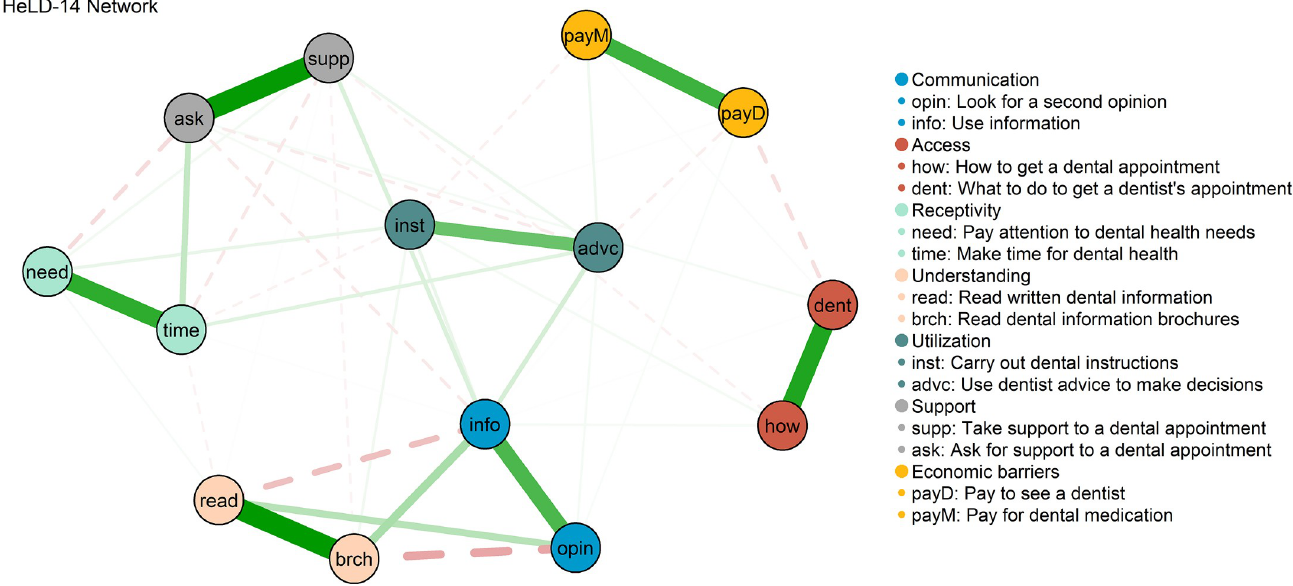
Fig 1. Estimated network for HeLD-14